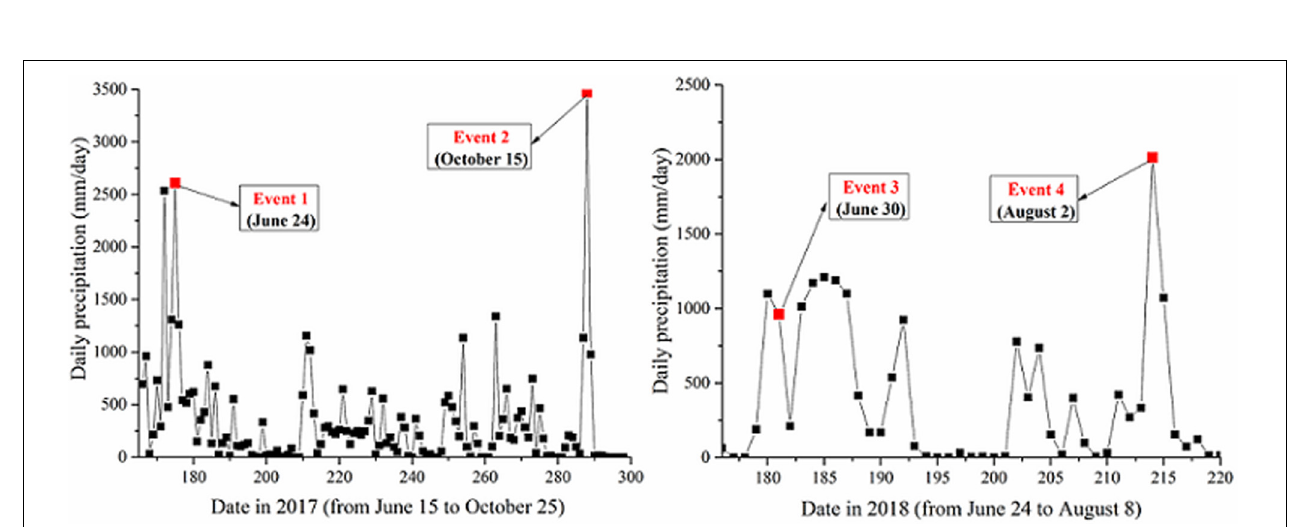
FIGURE 4 | The precipitation of selected events based on ground observations at daily scale (red square marks represent the selected events).